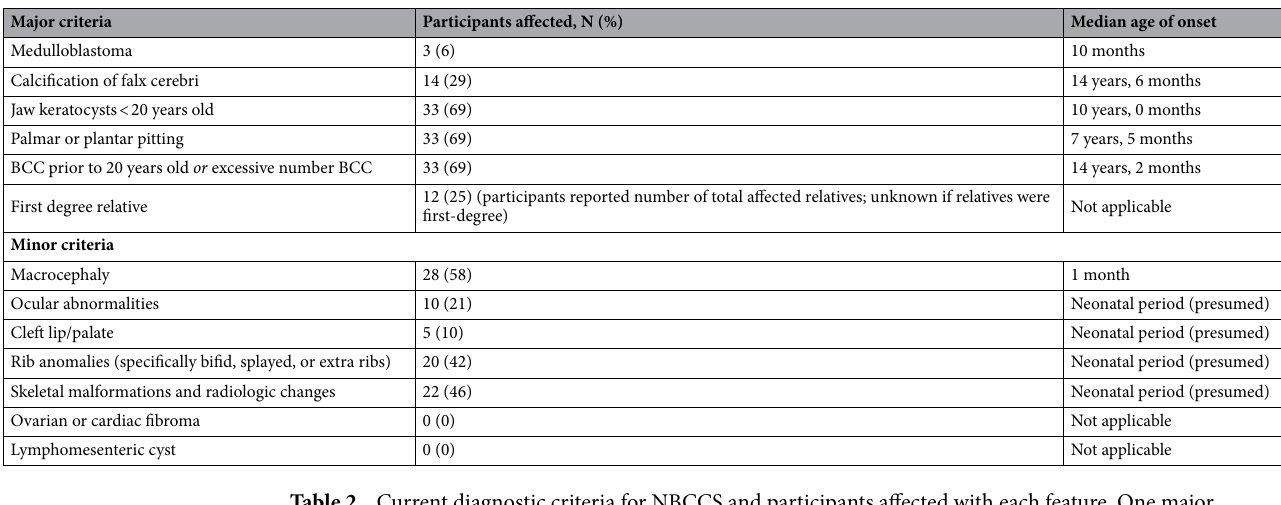
Table 2. Current diagnostic criteria for NBCCS and participants affected with each feature. One major criterion and molecular diagnosis, two major criteria, or one major criterion and two minor criteria are needed to make a diagnosis of NBCCS.